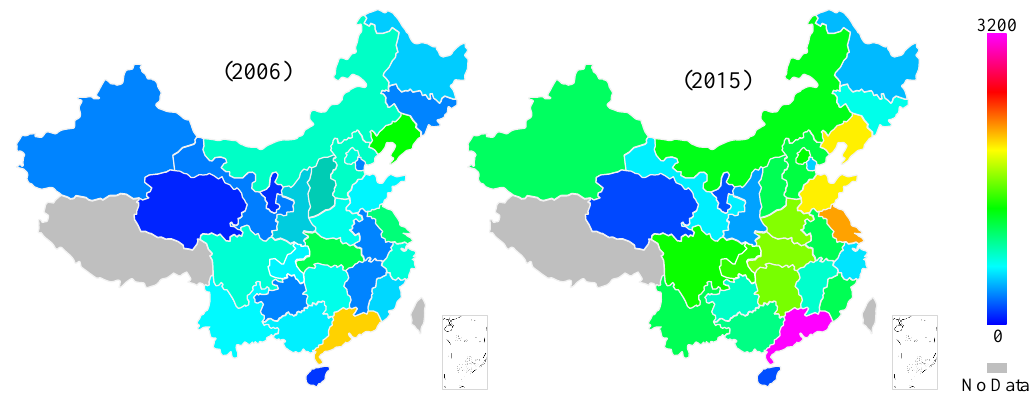
Figure 2. Energy consumption of the inter-provincial transportation sector in 2006 and 2015 (Unit: 10,000 tons of standard coal).